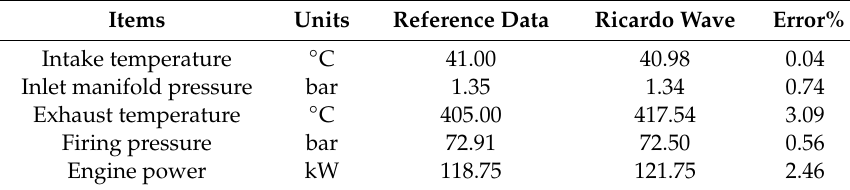
Table 2. Comparison between reference data and calculated results from Ricardo Wave at 25% engine load.